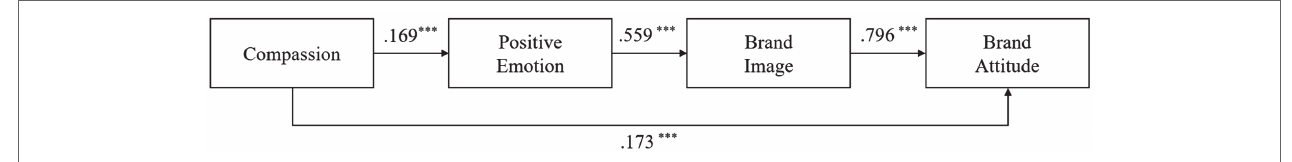
FIGURE 2 | Results for hypothesized model. *** p <